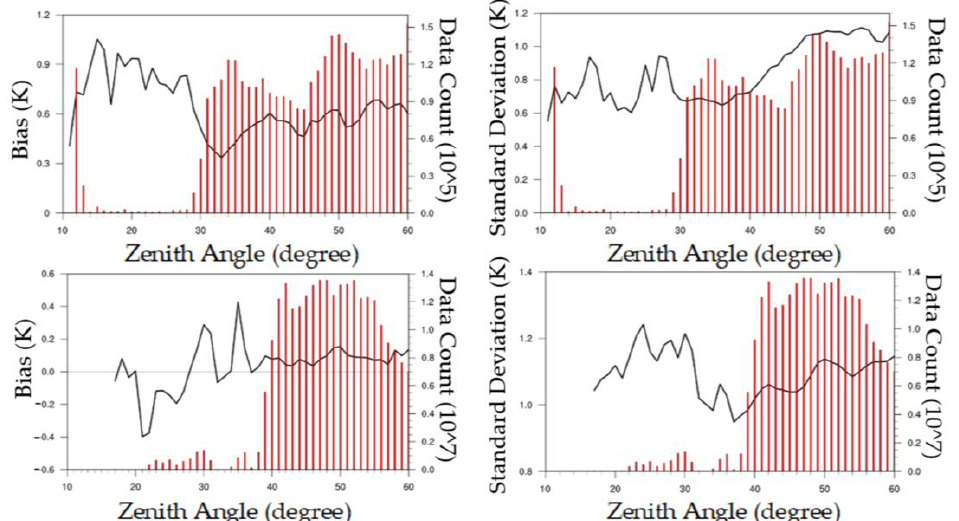
Figure 3. Bias ( left panels, unit: K) and standard deviation ( right panels, unit: K) vary with the zenith angle calculated from one-month data of AGRI, channel 10 ( upper panels), and AHI, channel 10 Figure 3. Bias (left panels, unit: K) and standard deviation (right panels, unit: K) vary with the zenith ( down panels). Red bars show data counts at different zenith angle calculated from one-month data of AGRI, channel 10 (upper panels), and AHI, channel 10 (down panels). Red bars show data counts at different zenith angles.